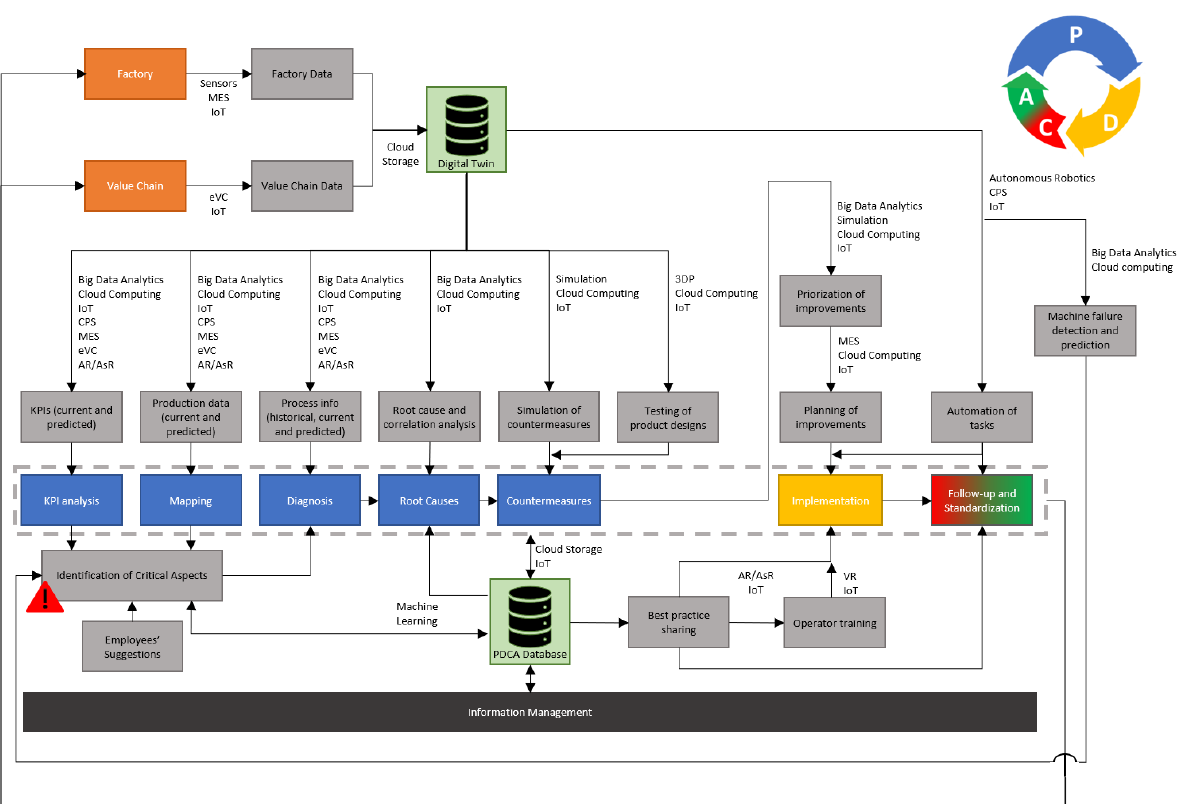
Figure 5. PDCA 4.0 Figure 5. PDCA 4.0 framework.